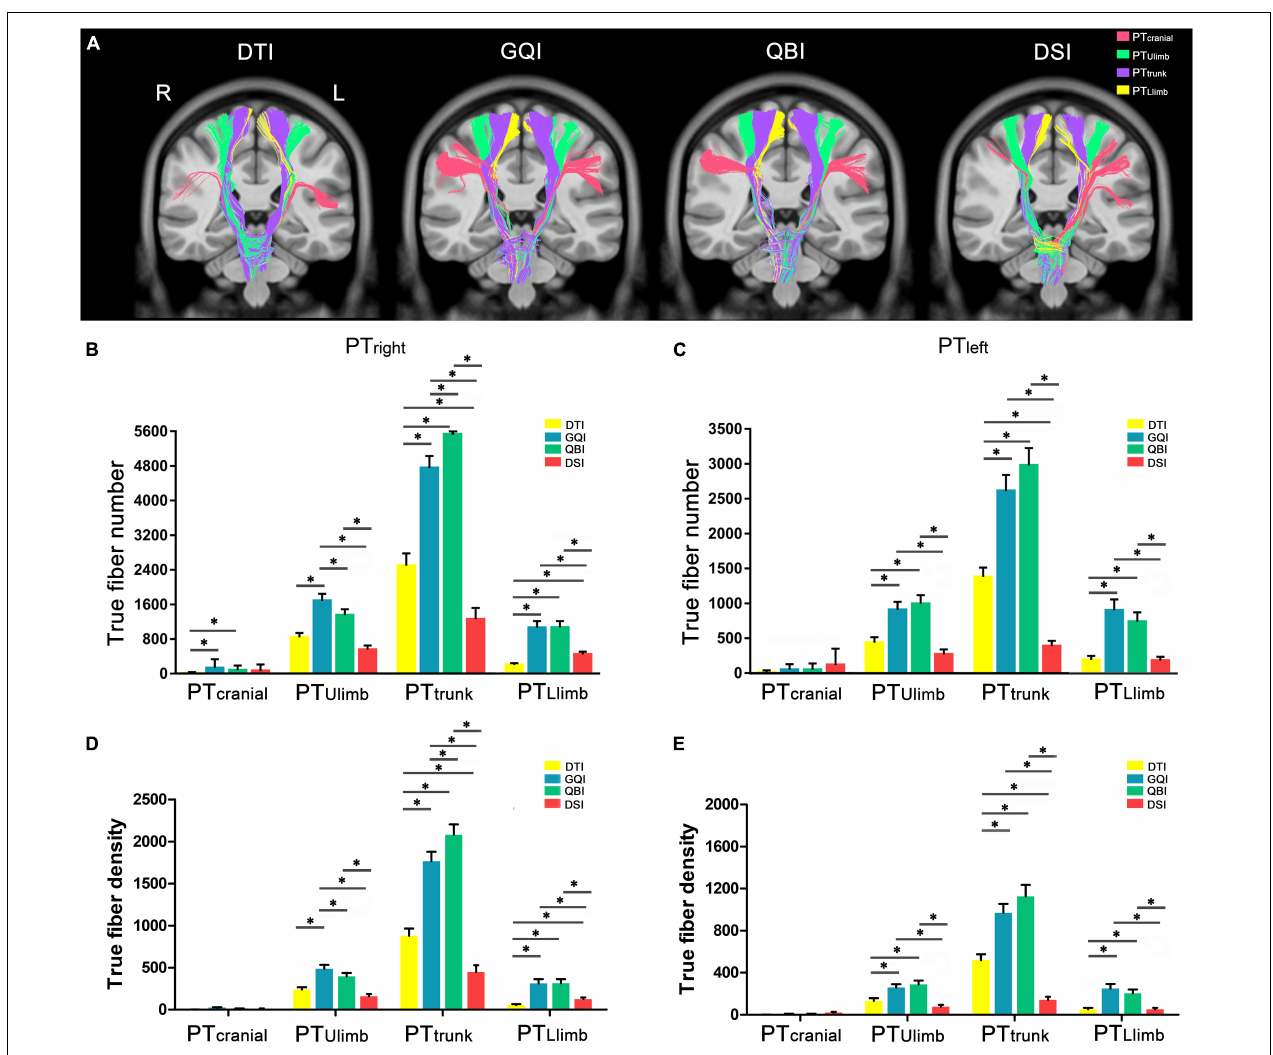
FIGURE 5 | Comparison of the true fiber number and density in PT branches. (A) An example of the true fibers of PT branches tracked based on four diffusion models. (B) The true fiber number of the right PT branches. (C) The true fiber number of the left PT branches. (D) The true fiber density of the right PT branches. (E) The true fiber density of the left PT branches. DTI, diffusion tensor imaging; DSI, diffusion spectral imaging; GQI, generalized Q-space sampling imaging; L, left; PT, pyramid tract; QBI, Q-ball imaging; R, right. * represents p < 0.0005 (0.05/96, Bonferroni corrected). The error bar represents standard